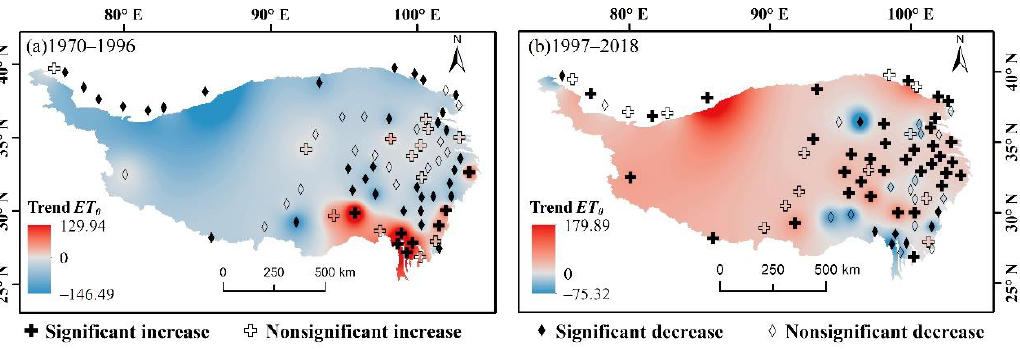
Figure 4. Spatial distribution of ET 0 trends on the TP during 1970–1996 ( a ) and 1997–2018 ( b ) (mm/10a).